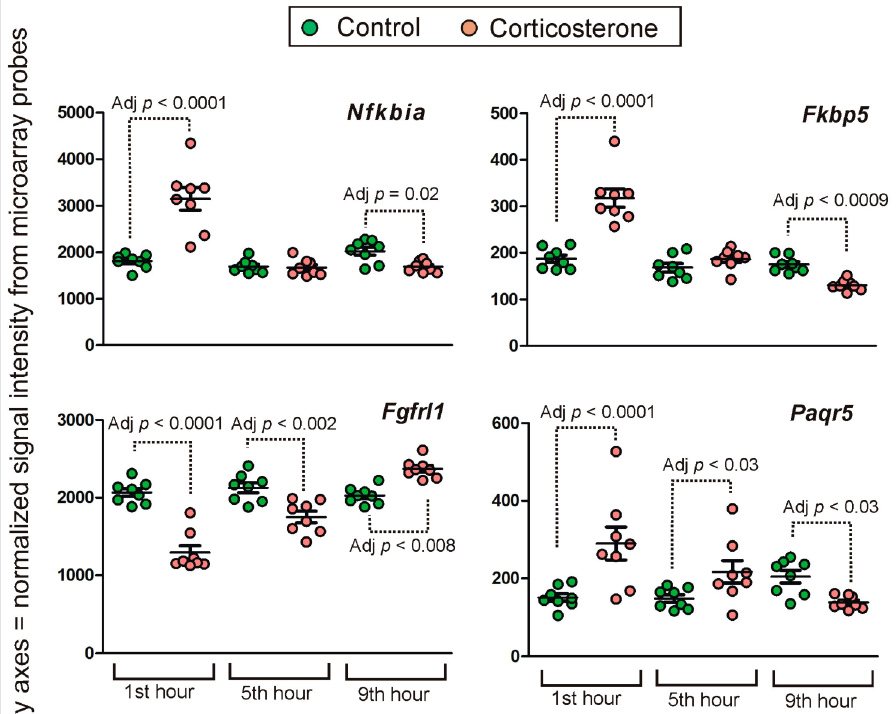
Figure 13. Examples of genes displaying time-dependent reversal of primary effects. Y axis indicates probe signal intensity decomposed into green and red channel after final background correction, within-array and between-array normalization. All data are available in File